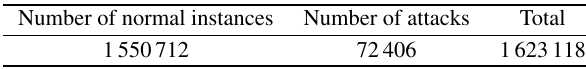
Table 4 Statistics of the